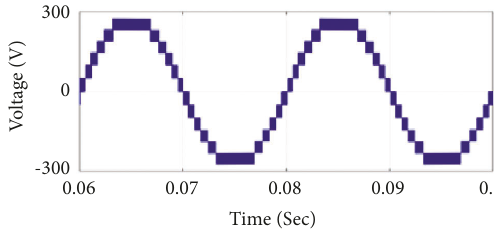
Figure 8: MLI output voltage (MI-0.99).